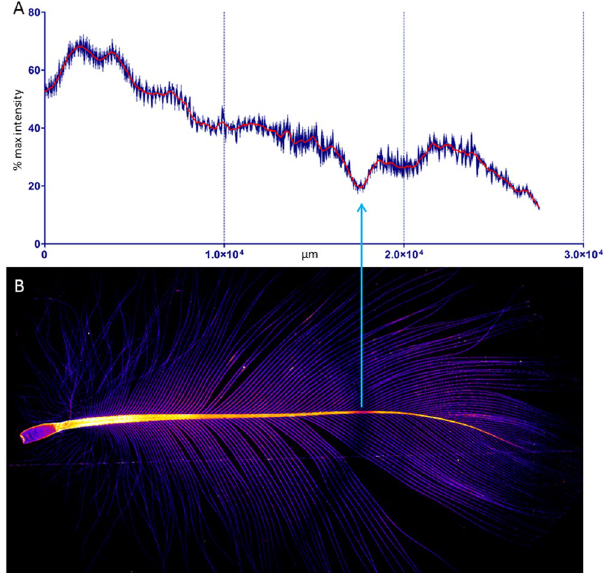
Figure 7. Br distribution within a Flesh-footed Shearwater breast feather. Image and line profile of a Flesh- footed Shearwater breast feather demonstrating a typical low concentration banding anomaly observed in in shearwater breast feathers. In contrast to Zn, the Br free banding is an inconsistent feature that does not correlate with any of the other distributions